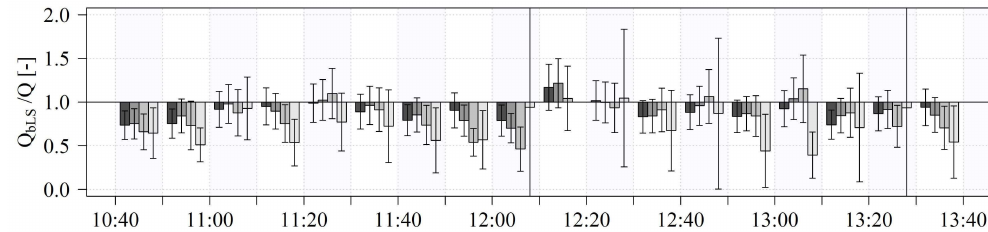
Figure 6. Calculated recovery rates Q bLS / Q from model runs without accounting for deposition. The order of the instrument position is given (within an interval) from left (darkest grey) to right (lightest grey) as near / bottom , near / middle , near / top , and far . Vertical lines indicate the 95% confidence region of the individual estimates. One interval from the measurement at position far (12h10 to 12h20, Q bLS / Q = 4.4) was excluded from the analysis.